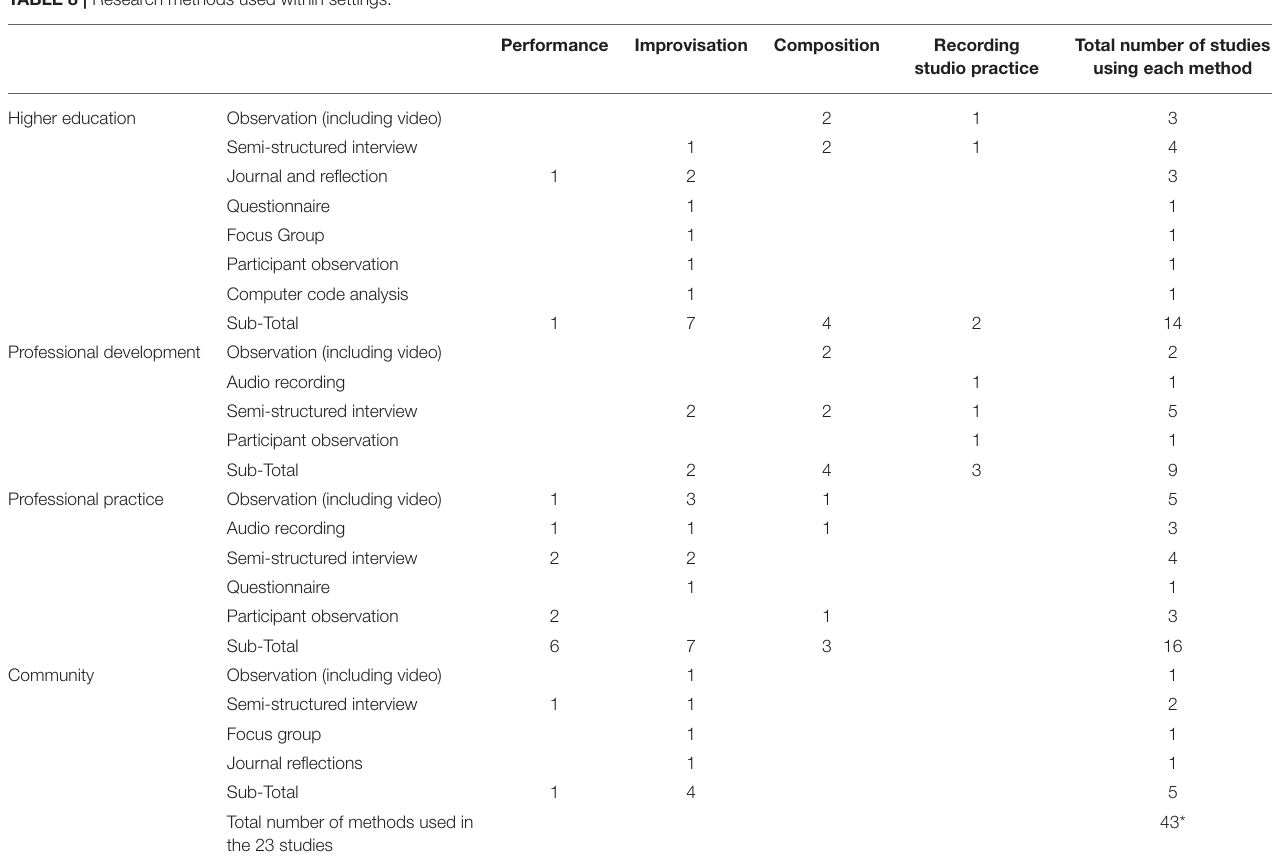
TABLE 8 | Research methods used within